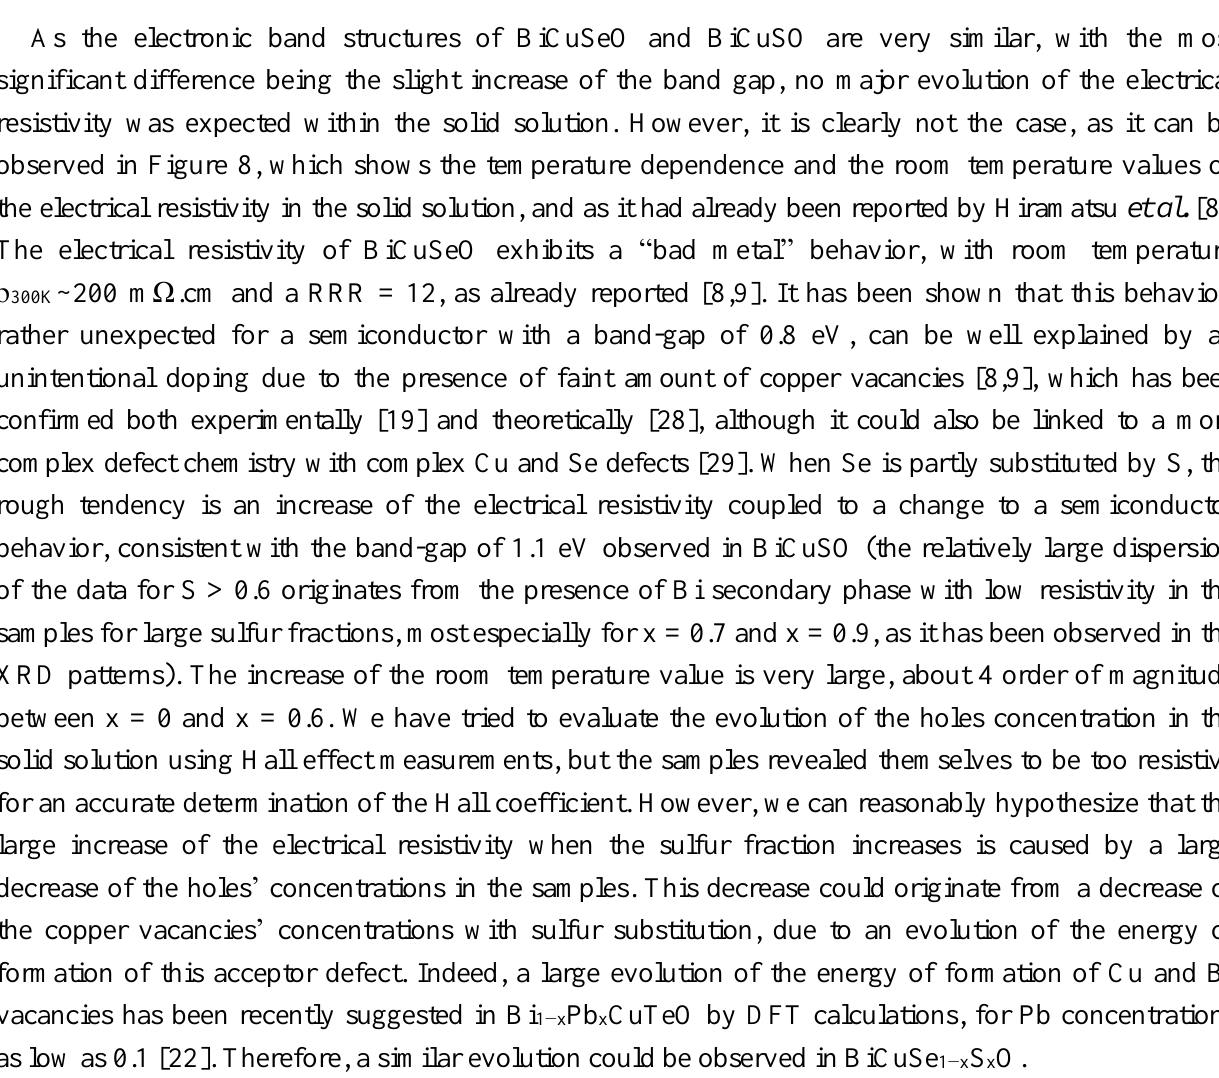
Figure 7. Evolution of the room temperature value of the thermal conductivity in the BiCuSe 1−x S x O solid